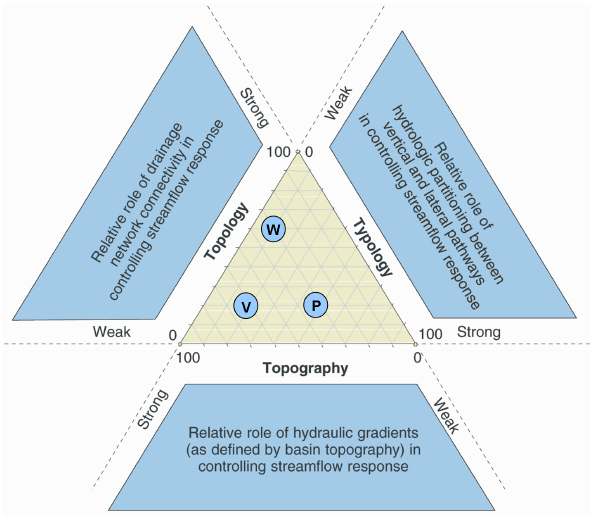
Fig. 12. The relative influence of topography, topology and typol- ogy on the shallow soil moisture and ground thaw interaction. The higher the number in the ternary diagram, the greater the control. P is peatland site, V is valley site and W is wetland site. Modified from Buttle (2006). Locations were approximated based on